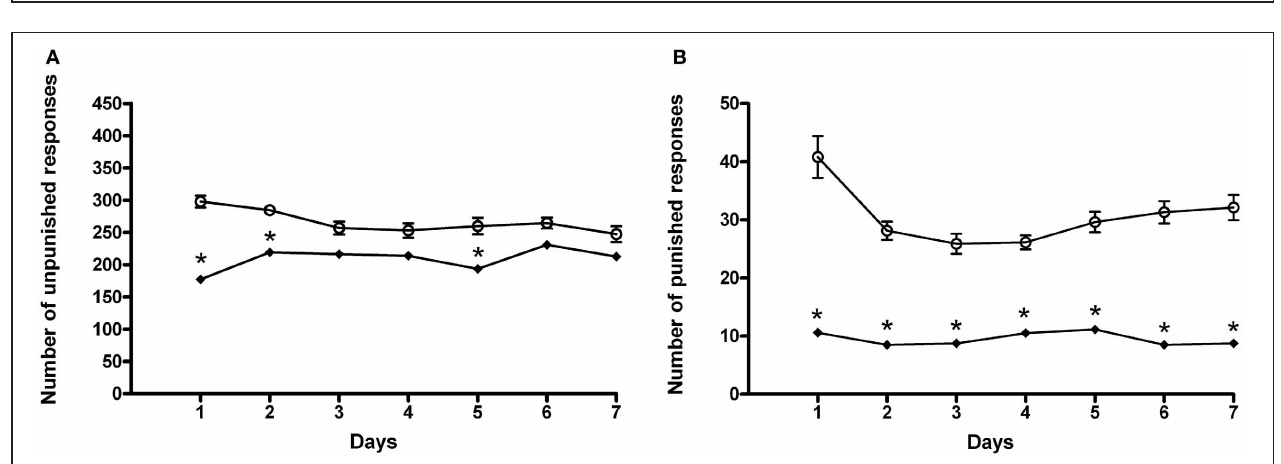
FIGURE 5 | Effects of the administration of AM281 on the number of unpunished (A) and punished (B) responses during the conflict periods in ACD treated rats. Each value represents the means ± S.D. of sixteen rats. ∗ p < 0 . 001 vs. control groups. ( ) ACD, ( ) (ACD-AM281).